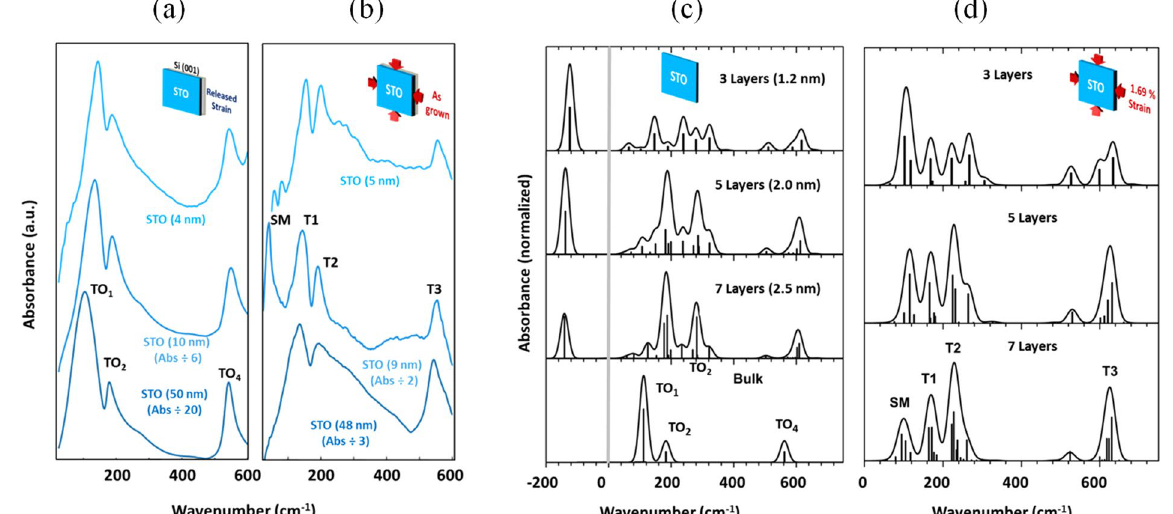
Figure 1. Measured and calculated absorbance of STO thin films with various thicknesses and strain states. ( a) IR absorbance of the unstrained STO/Si(001) films of thickness 50, 10 and 4 nm. The three phonon structures TO 1 , TO 2 and TO 4 correspond to the classification of the bulk phonon modes. ( b) IR absorbance of the strained (as-grown on Si) STO/Si(001) films of thickness 48, 9 and 5 nm. The four main structures of the intermediate film are labelled SM, T1, T2, T3, where SM designates surface and/or soft mode and T1, T2, T3 bulk-like modes (see details in the text). Differences in the spectra of the two thicker films may be related to the difference in their relaxation mechanism (See refs 40 and 41). The plastic relaxation of the as-grown 48 nm film causes small domains bordered by dislocations at the interface. ( c ) Calculated absorbance of STO bulk and fully relaxed STO slabs of 7 layers (2.5 nm), 5 layers (2 nm) and 3 layers (1.2 nm). The presence of modes at negative values (imaginary modes) demonstrates that all slabs are metastable. ( d ) Calculated absorbance of STO slabs of 7, 5 and 3 layers with − 1.69% strain corresponding to the lattice mismatch between STO and Si(001). Modes are labelled as in ( b) . In ( c – d) sticks are proportional to oscillator strength (maximum intensity normalized at 1) and lines represent the sum of 30 cm − 1 wide Gaussians each centered at the modes